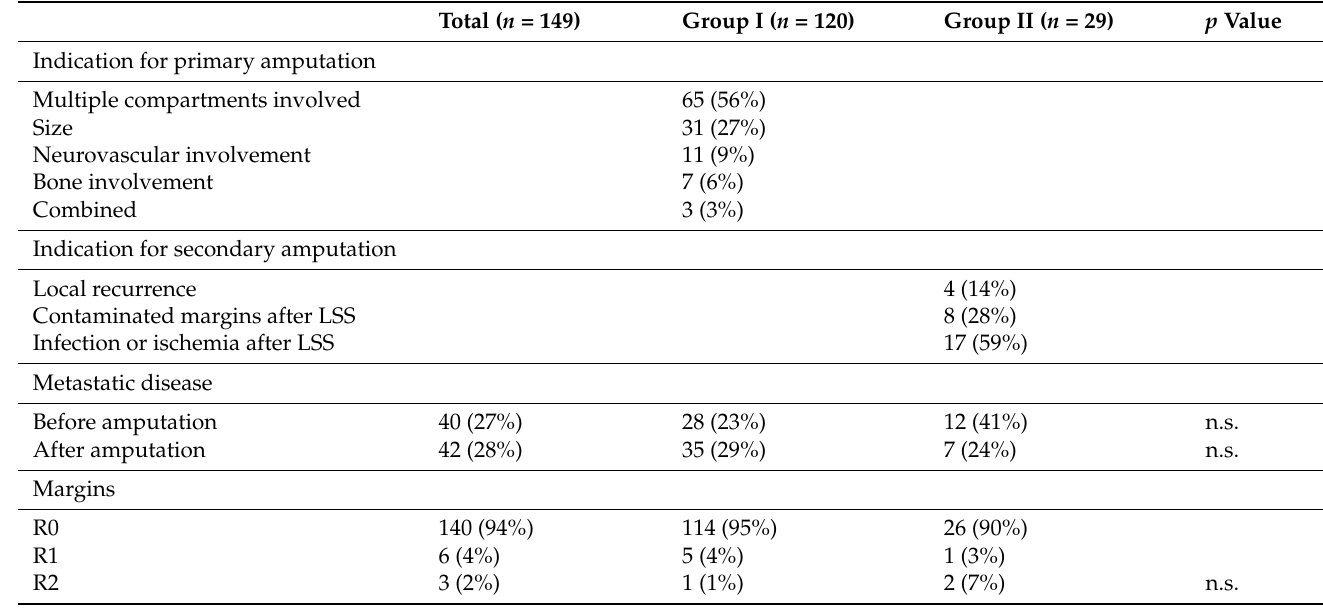
Table 1. Indications, metastatic disease, adjuvant therapies and outcomes data. Percentage in